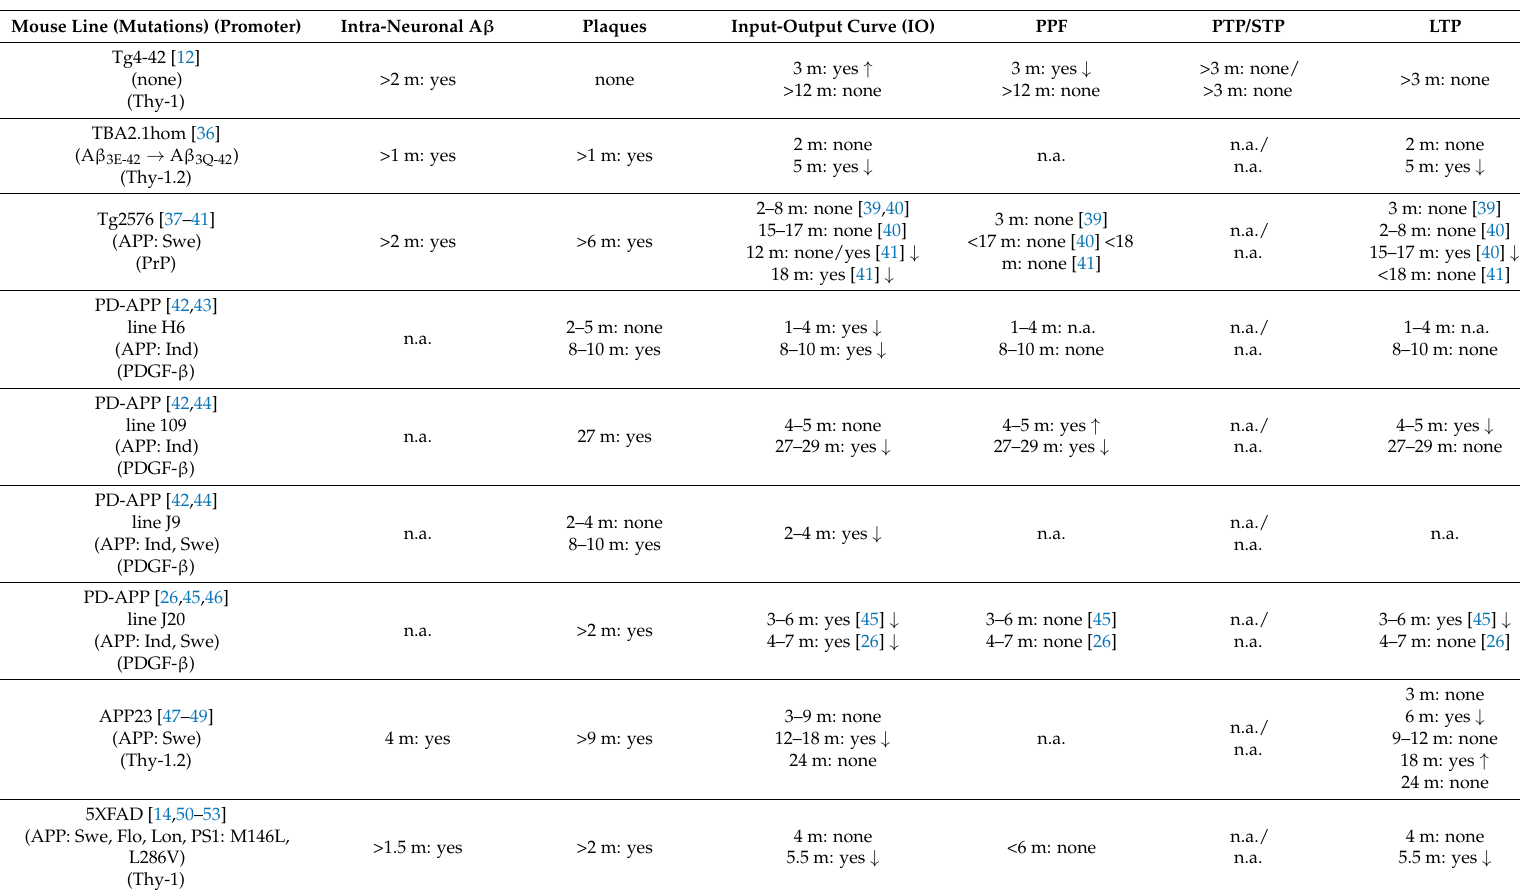
Table 1. Overview of neurophysiological alterations in hippocampal slices from transgenic Alzheimer mouse models. Electrophysiological recordings of fEPSPs in CA1 subfield (adapted from [16])